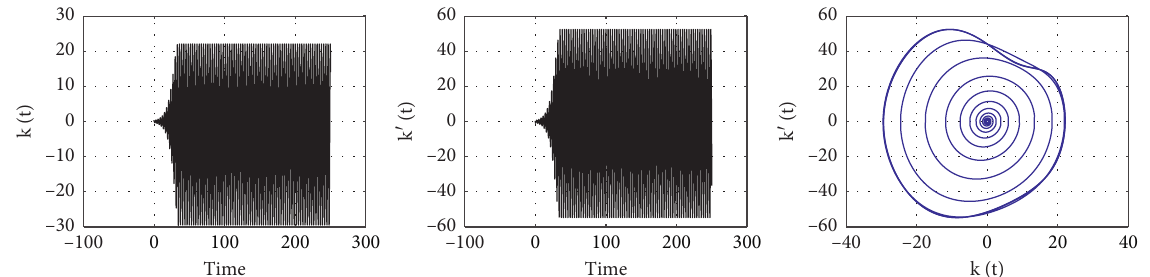
Figure 17: Solutions and phase trajectories at a � 0.125, q � 1, and τ � 1.